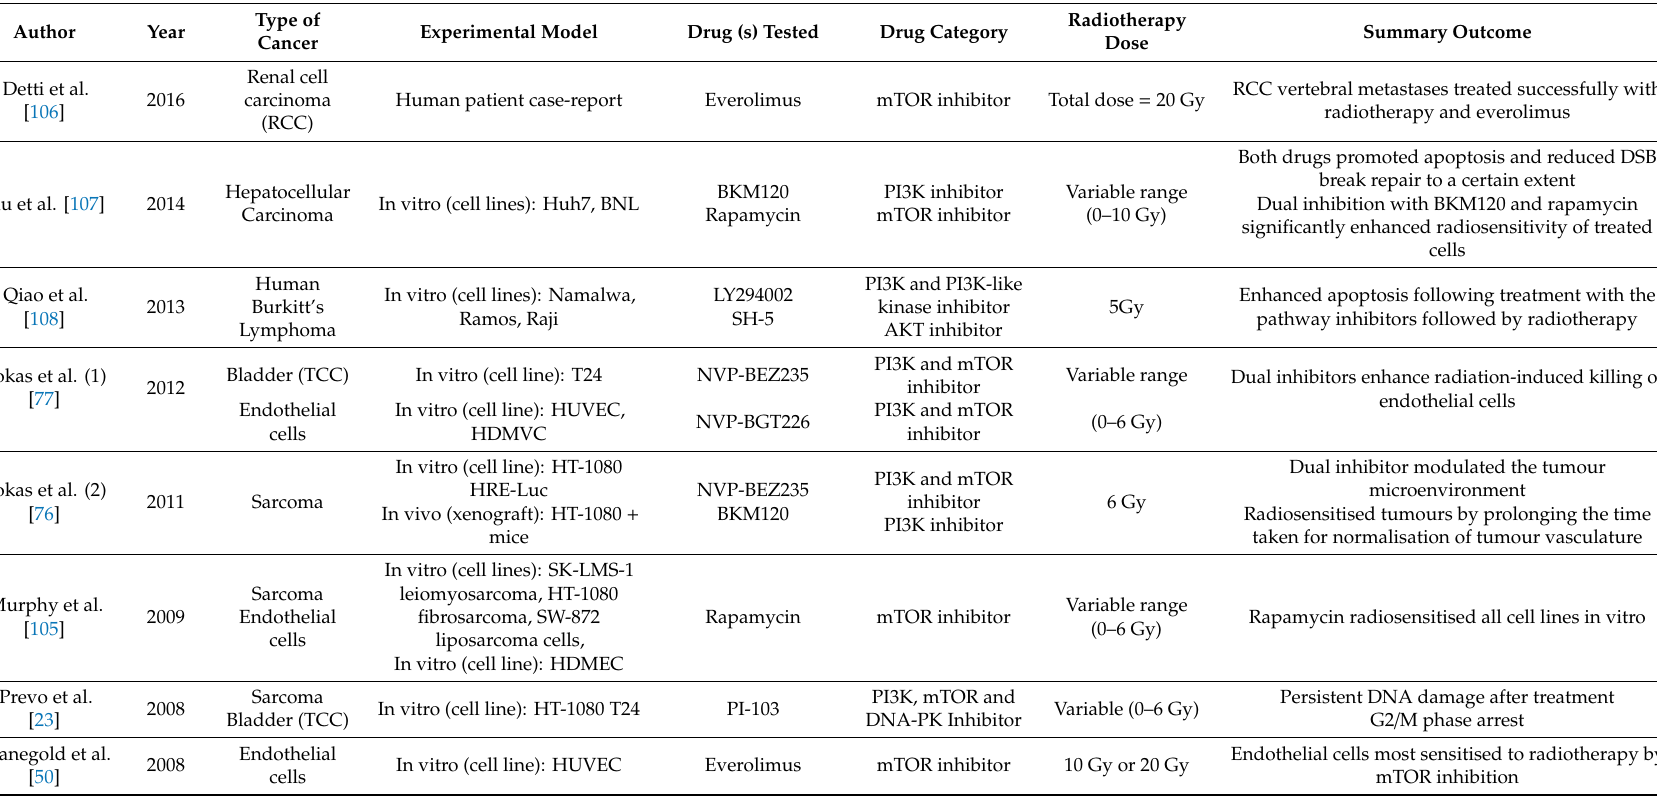
Table 4. Preclinical studies exploring the role of PI3K, AKT and / or mTOR inhibitors radiosensitising other types of